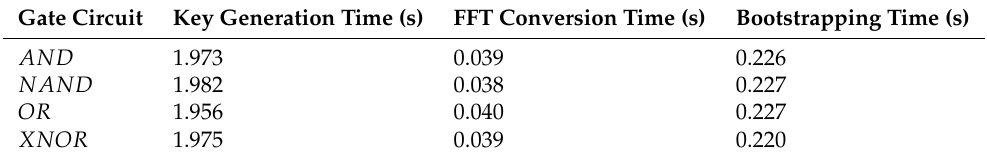
Table 5. Experimental results for single circuit gates.